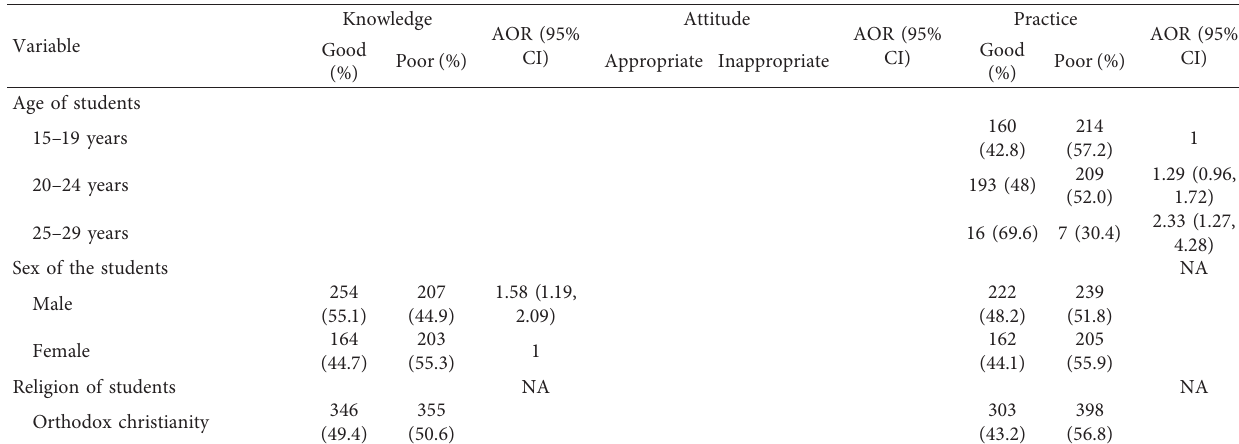
Figure 1: Proportion of knowledge, attitude, and preventive practice of preparatory school students on STIs, West Gojjam zone, Northwest Ethiopia, 2018. Table 5: Factors associated with knowledge, attitude, and preventive practice on STIs among preparatory school students, West Gojjam zone, Northwest Ethiopia,